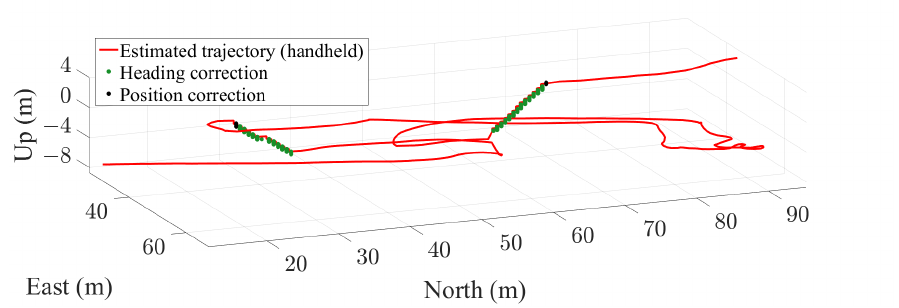
Figure 22. Estimation of a passenger’s trajectory in a traffic hub with a handheld smartphone. The green and black dots represent, respectively, the points where heading and position updates are applied.